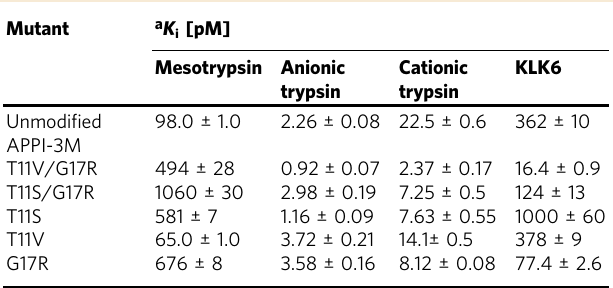
a Results (means±SD) were obtained from three independent experiments